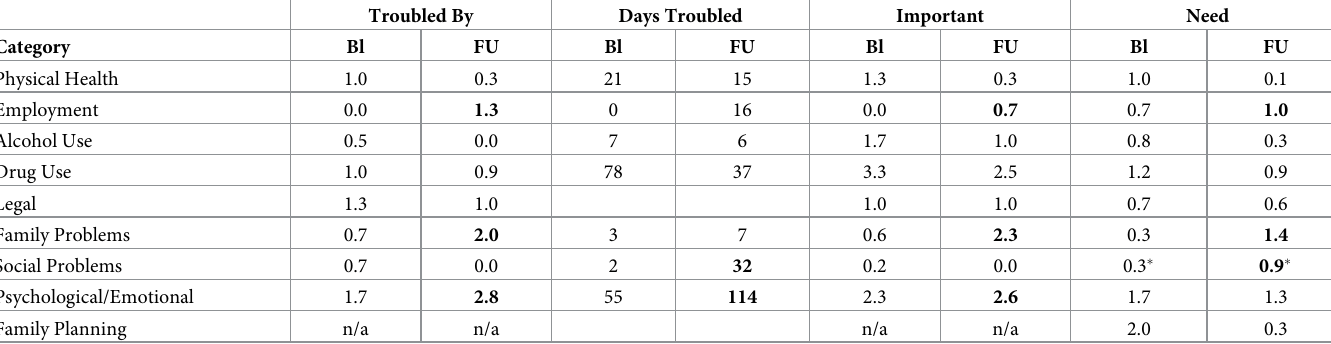
Table 3. Means of Scores for Client Ratings of Troubled By, Number of Days Troubled in the Last Month, and Importance, at Baseline and Follow-up for ASI Categories. Troubled By Days Troubled Important